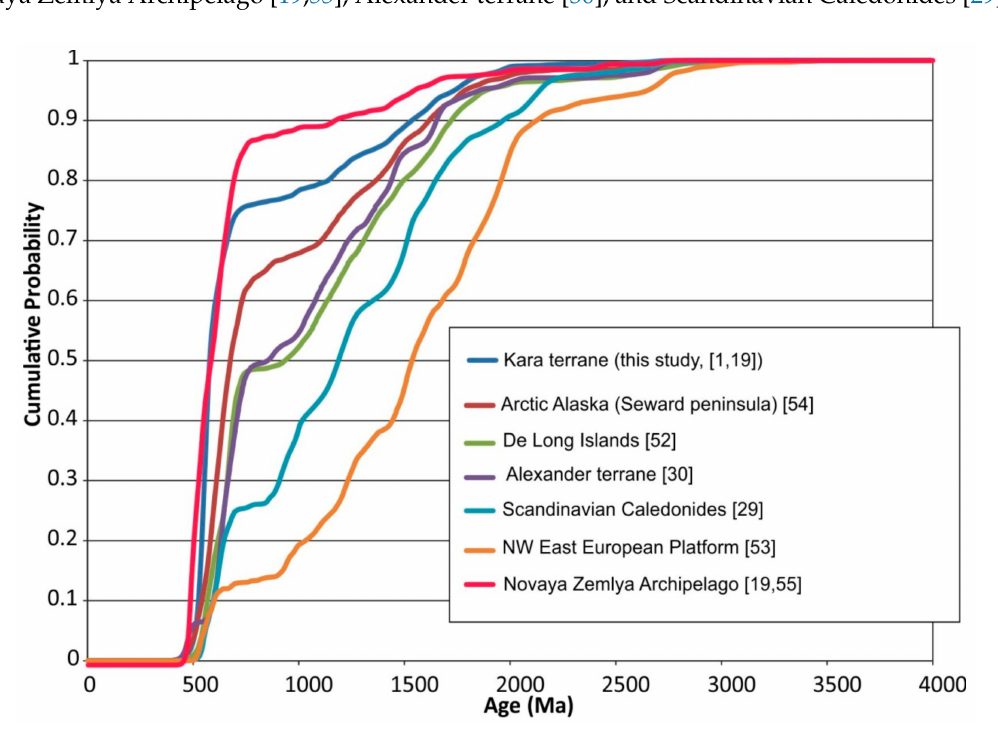
Figure 6. Cumulative probability diagram for U–Pb detrital zircon ages from Lower Paleozoic rocks of the Kara Terrane (this study, [1,19]), Alexander Terrane [30], Scandinavian Caledonides [29], De Long Islands (Henrietta and Jeannette islands) [52], Novaya Zemlya Archipelago [19,55], the NW European Platform [53], and Arctic Alaska